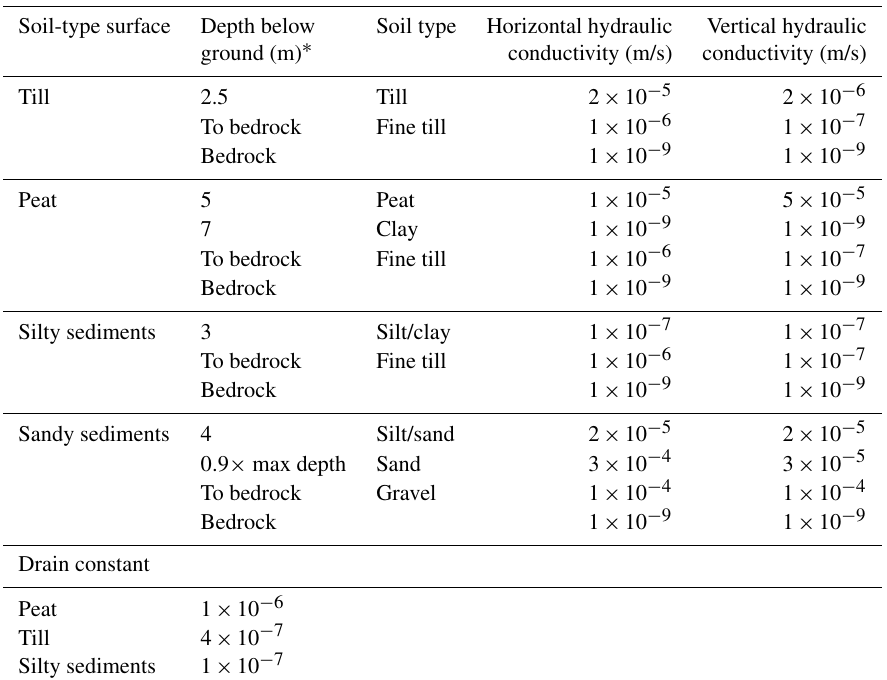
Table 3. Flow model setup . Flow model setup from the calibrated and validated Mike SHE model presented in Jutebring Sterte et al. (2018). The “soil-type surface” corresponds to the soil type shown in Fig. 1b. A drain constant was used to account for coarser material of the upper half metre of the